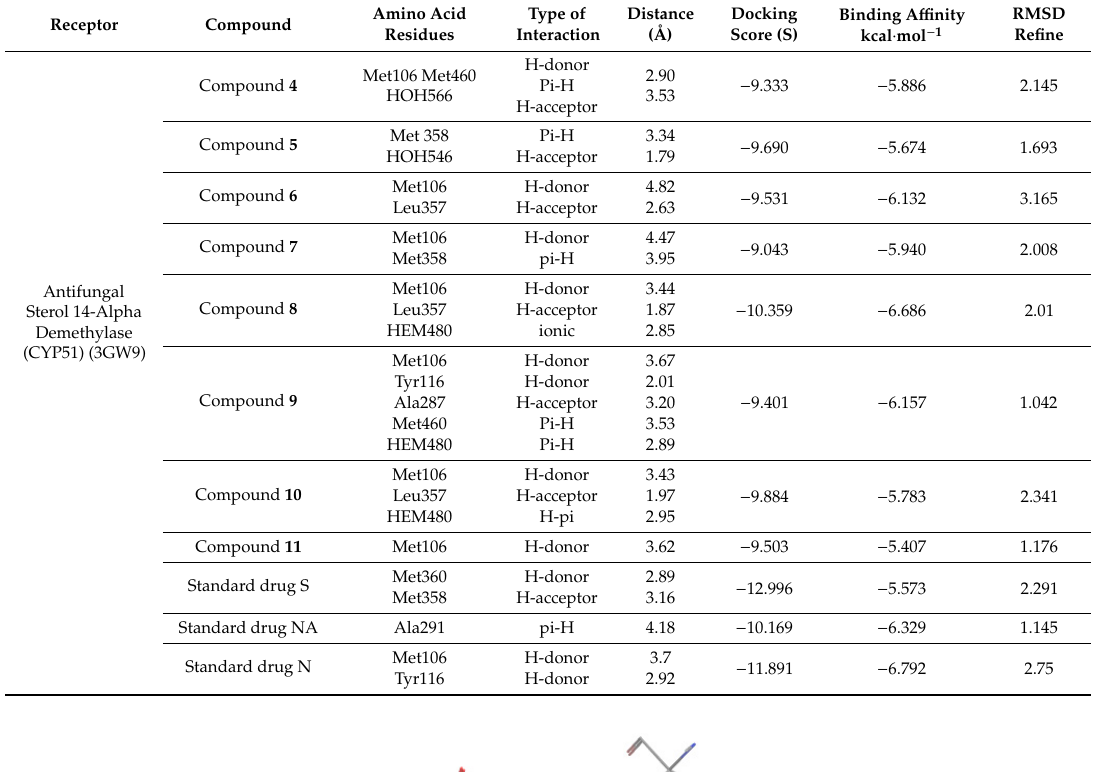
Table 3. Predicted binding-free energies ( ∆ Gbind) for ligands 4 – 11 .